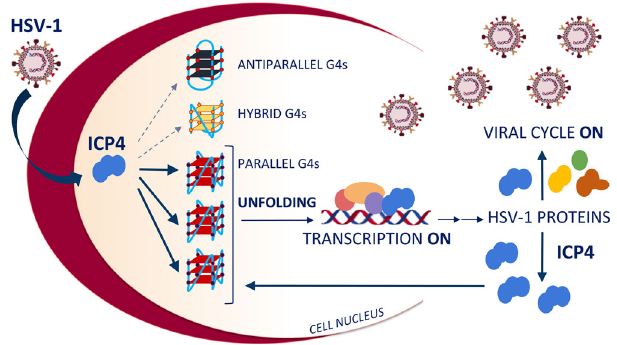
Fig. 6 Model of ICP4 activity at G4s in viral IE promoters in HSV-1 infected cells. Schematic of the herpesvirus transcription factor ICP4 regulating viral gene expression and boosting its own expression through binding to parallel DNA G-quadruplexes